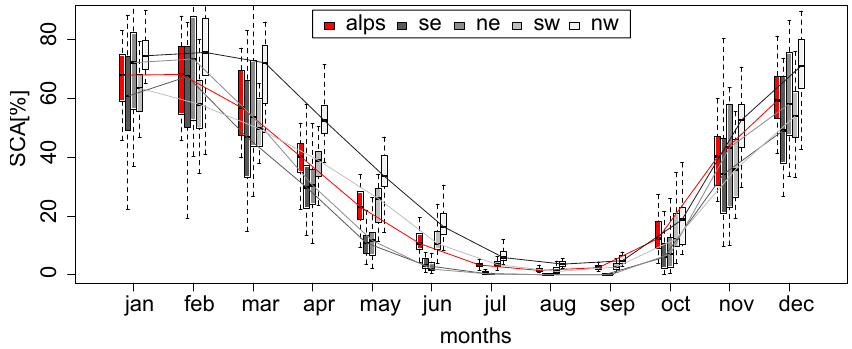
Fig. 7. Monthly median and Inter Quartile Range (IQR) of SCA averaged over the period 1985–2011 for the whole Alpine region (red) and all four subregions (gray tones) over the course of the year. SCA values are given in numbers relative to the size of the respective region (cf. Tab. 1). To facilitate interpretation, lines connect median values from each month.